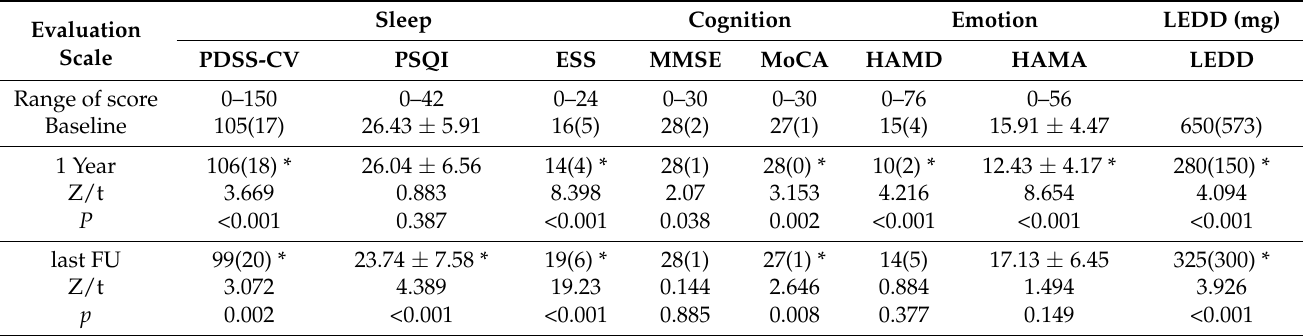
Table 3. Changes in sleep, cognition, and mood scores and LEDD in older ( ≥ 75 years old) PD patients at baseline, 1 year post operation, and final